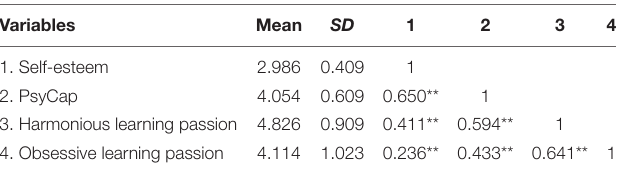
TABLE 2 | Means, standard deviations ( SD ) and Pearson correlations of variables ( N = 1,218).